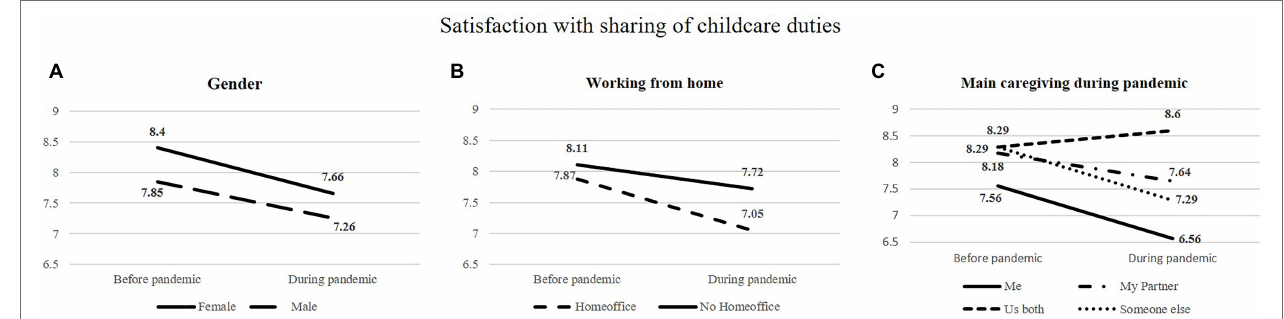
FIGURE 2 | Satisfaction with the sharing childcare duties before and during the Covid-19 pandemic. Assessed via repeated measure statistics. (A) Satisfaction with the sharing of childcare duties in dependence of gender of the participants. While satisfaction with the sharing of childcare duties decreased for all participants during compared to before the pandemic, no difference was seen in regard to gender of the participants. (B) Satisfaction with the sharing of childcare duties in dependence of working from home. Working from home was associated with a lower satisfaction with the sharing of childcare duties and a stronger decrease during compared to before the pandemic (interaction significant). (C) Satisfaction with the sharing of childcare duties in dependence of who mainly has taken care for the children during lockdown. Satisfaction was significantly lower in participants who mainly have been taking care by themselves compared to participants who shared childcare equally.